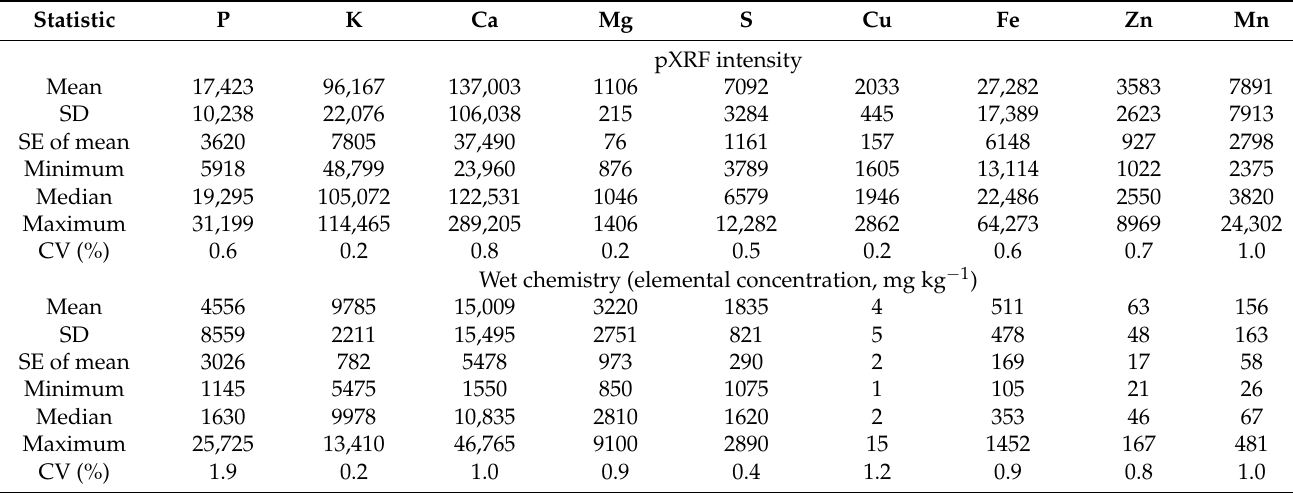
Table 2. Summary statistics of plant elemental values, as determined by portable X-ray fluorescence (net intensity) and inductively coupled plasma atomic emission spectroscopy (elemental concentrations) ( n = 8)